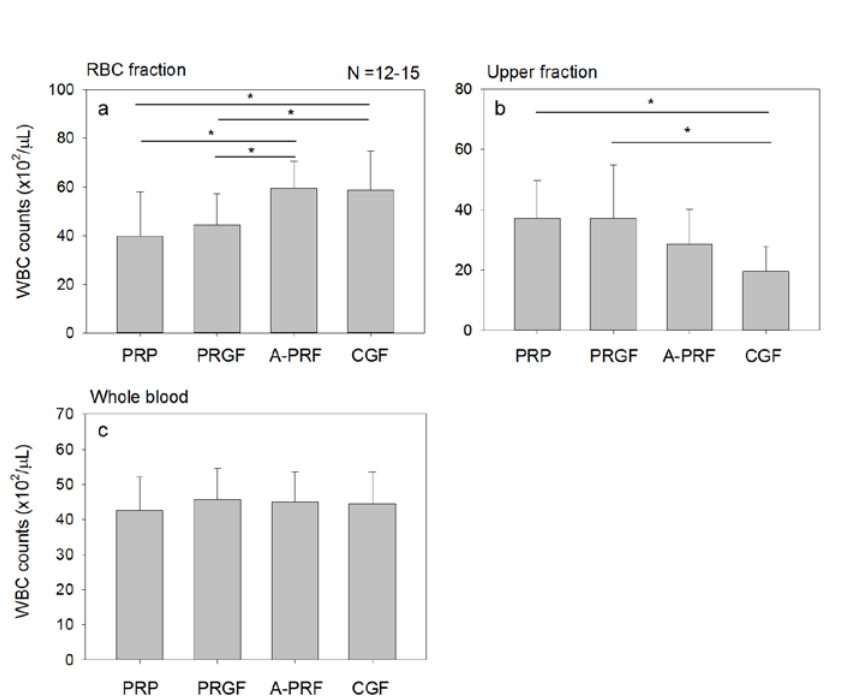
Figure 1. WBC counts in the RBC fraction ( a ), upper plasma fraction ( b ), and whole blood sample ( c ). Peripheral blood samples were collected in the presence of the anti-coagulant and centrifuged by the individual centrifugation protocols. The upper fraction was collected above the line indicated in Table 1. The remainder of the fractionated sample was used as the RBC fraction. N = 12–15. The asterisks represent statistically significant difference ( p < 0.05).